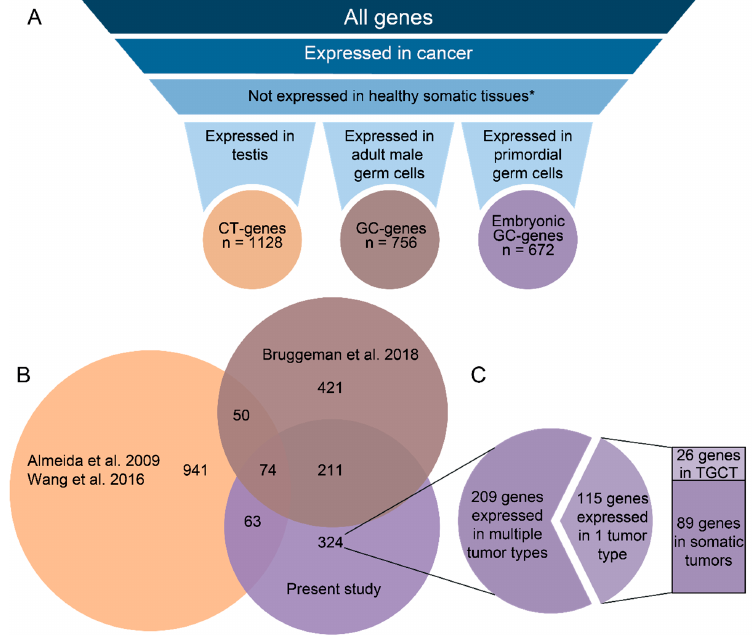
Figure 1. ( A ) Visualization of how cancer/testis (CT) and germline/cancer (GC) genes have been identified. Left: genes included by Wang et al. [6] and Almeida et al. [5] have been based on gene expression in whole testis tissue (CT genes). Middle: genes included by Bruggeman et al. [7] have been based on gene expression in germ cells (GC genes). Right: Genes included in the present analysis have been included based on gene expression in human primordial germ cells (GC genes). * = testis and ovary were excluded as they are not considered somatic. ( B ) Approximately half of the embryonic GC genes have not yet been described before as GC genes or CT genes. Venn diagram comparing the present analysis of human GC genes expressed in primordial germ cells (red) to earlier identified GC genes expressed in adult germ cells [8] and cancer / testis (CT) genes [5,6] (Data S1A). ( C ) The majority of newly identified embryonic GC genes are expressed in multiple tumor types. From the 115 genes expressed in only one tumor type, 26 are expressed in testicular germ cell tumors (TGCTs), showing that the majority of GC genes are expressed in tumors that originate from somatic